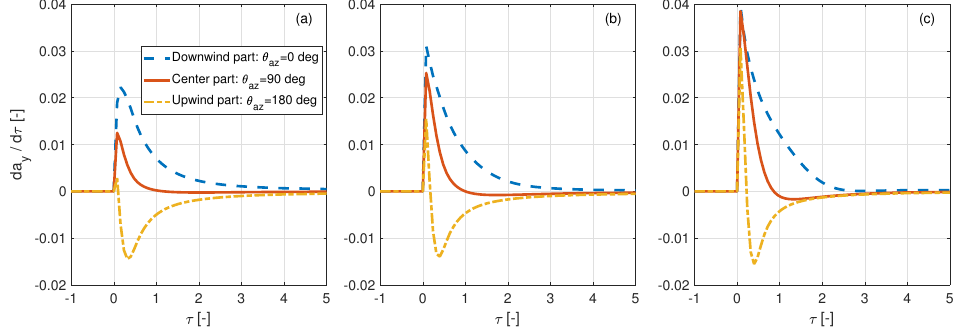
Φ Φ Φ y = 15 deg, ( b ) y = 30 deg, ( c ) y = 45 deg.